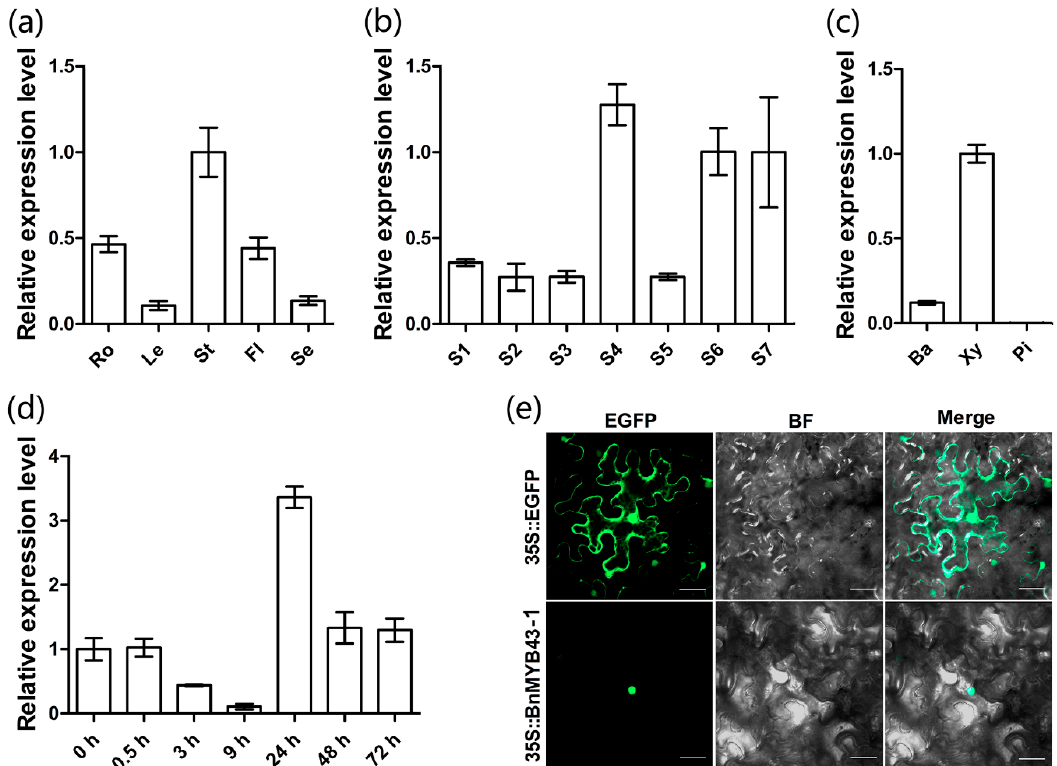
Figure 1. Expression pattern of BnMYB43 gene family in oilseed rape and subcellular localization of BnMYB43-1 in Nicotiana benthamiana . ( a ) Expression analysis of BnMYB43 gene family in organs of B. napus. ( b ) Expression analysis of BnMYB43 gene family in stems of B. napus . ( c ) Expression analysis of BnMYB43 gene family in stem tissues of B. napus . ( d ) Expression analysis of BnMYB43 gene family after inoculation by S. sclerotiorum . ( e ) Subcellular localization of BnMYB43-1 in the nucleus. The expression levels were relative to stem ( a ), S7 ( b ), Xy ( c ) and 0 h ( d ), which were set to 1. Expression level of 25SrRNA was used as a control reference gene. Ro, root; Le, leaf; St, stem; Fl, flower;